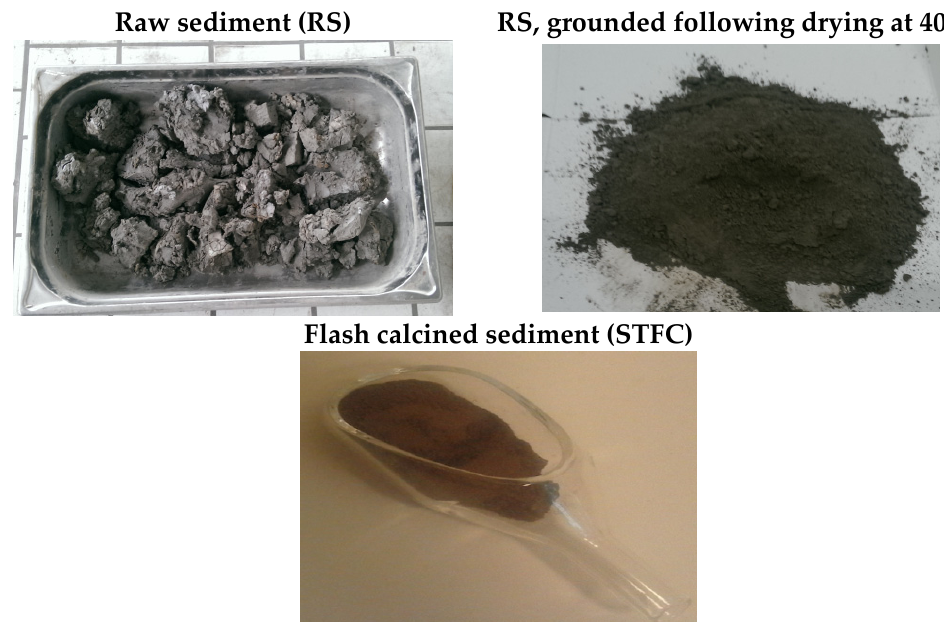
Figure 1. The visual aspect of sediment through treatment stages.